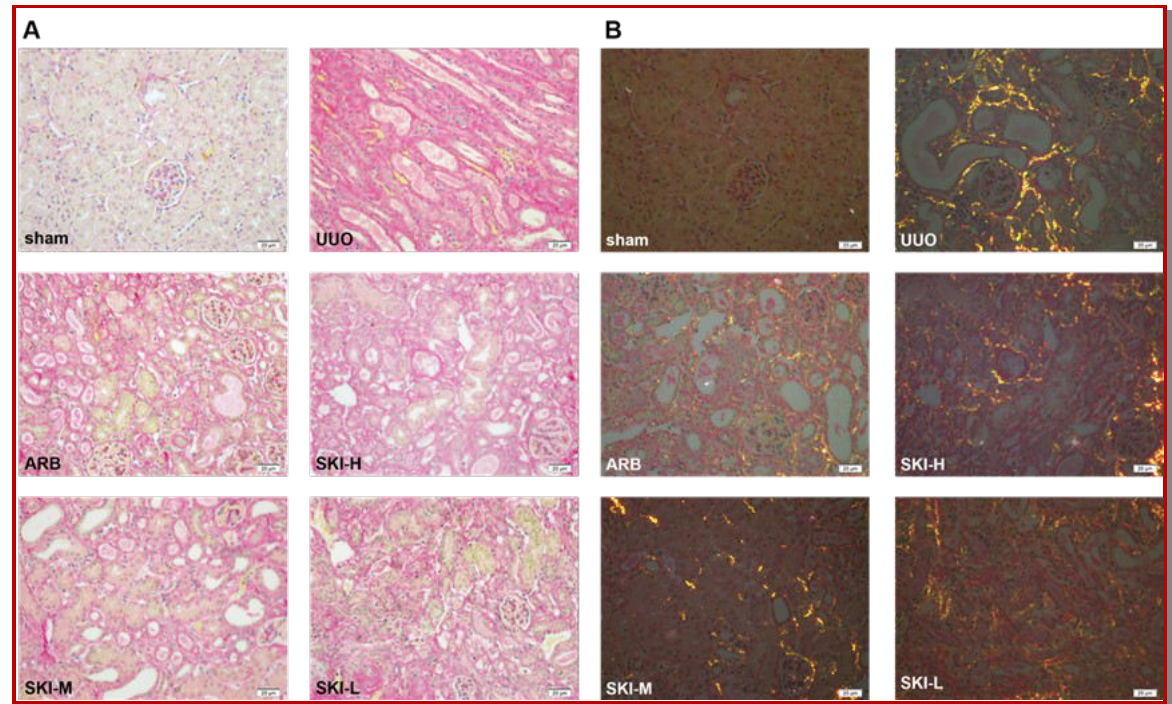
Figure 4: Effects of shenkang injection on renal fibrosis. Kidney biopsies were strained by sirius red stain to observe fibrotic le- sions. (A) Sirius red stain, 400x, natural light; (B) Sirius red stain, 400x, polarized light; SKI-H means shenkang injection (7.8 g/kg); SKI-M means shenkang injection (3.9 g/kg); SKI-L means shenkang injection (1.95